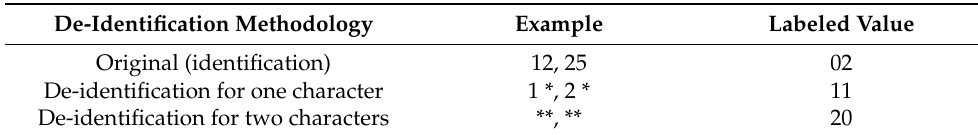
Table 2. Labeling rule for age. An asterisk (*) indicates a de-identified character from personal information.